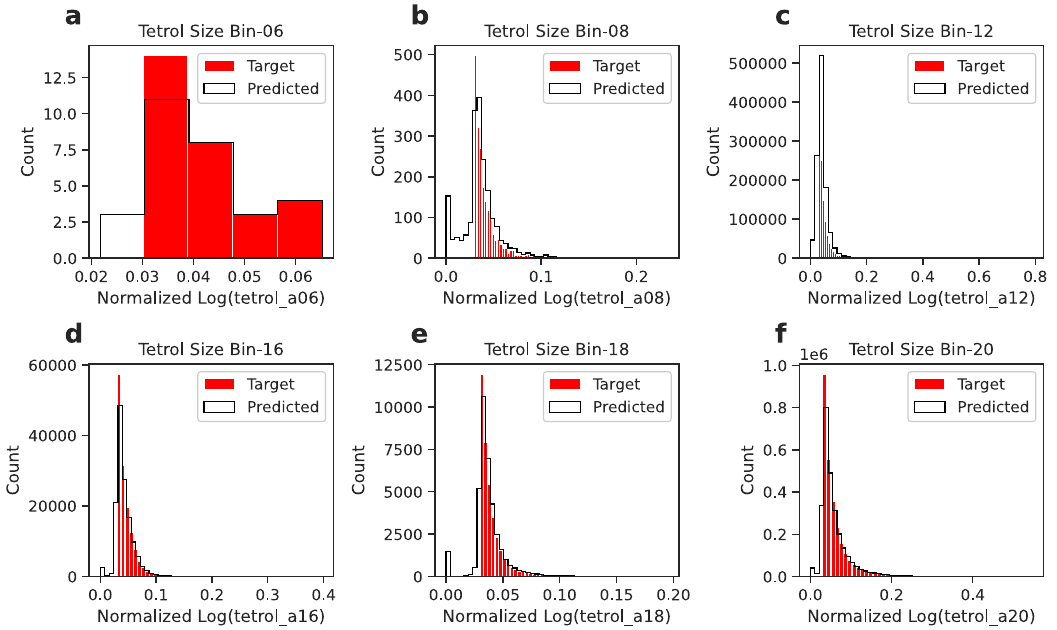
Fig. 6 WRF-Chem default (target) and WRF-Chem DNN (predicted) particle-phase tetrol distributions. a – f Selected Tetrol size bins 6, 8, 12, 16, 18, and 20 correspond to particles with diameter ranges of 9.8 – 15.5 nm, 24.6 – 39.1 nm, 156.2 – 248.0 nm, 1.0 – 1.6 µm, 2.5 – 4.0 µm, and 6.3 – 10.0 µm, respectively. Here the distribution is for the full 3D WRF-Chem domain during the 6-day simulation